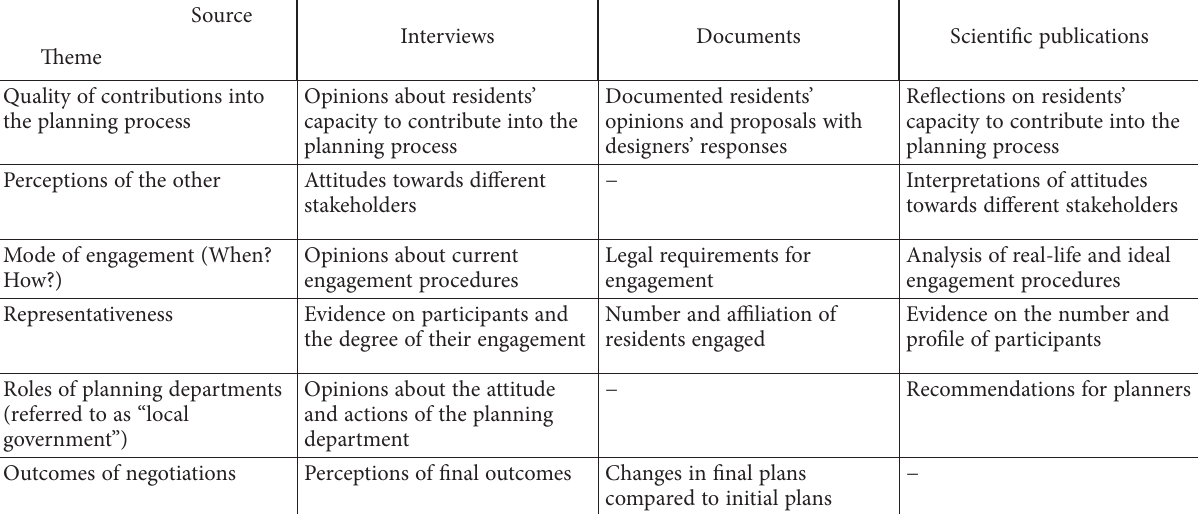
Table 1. Matrix of data sources and emerging themes (source: